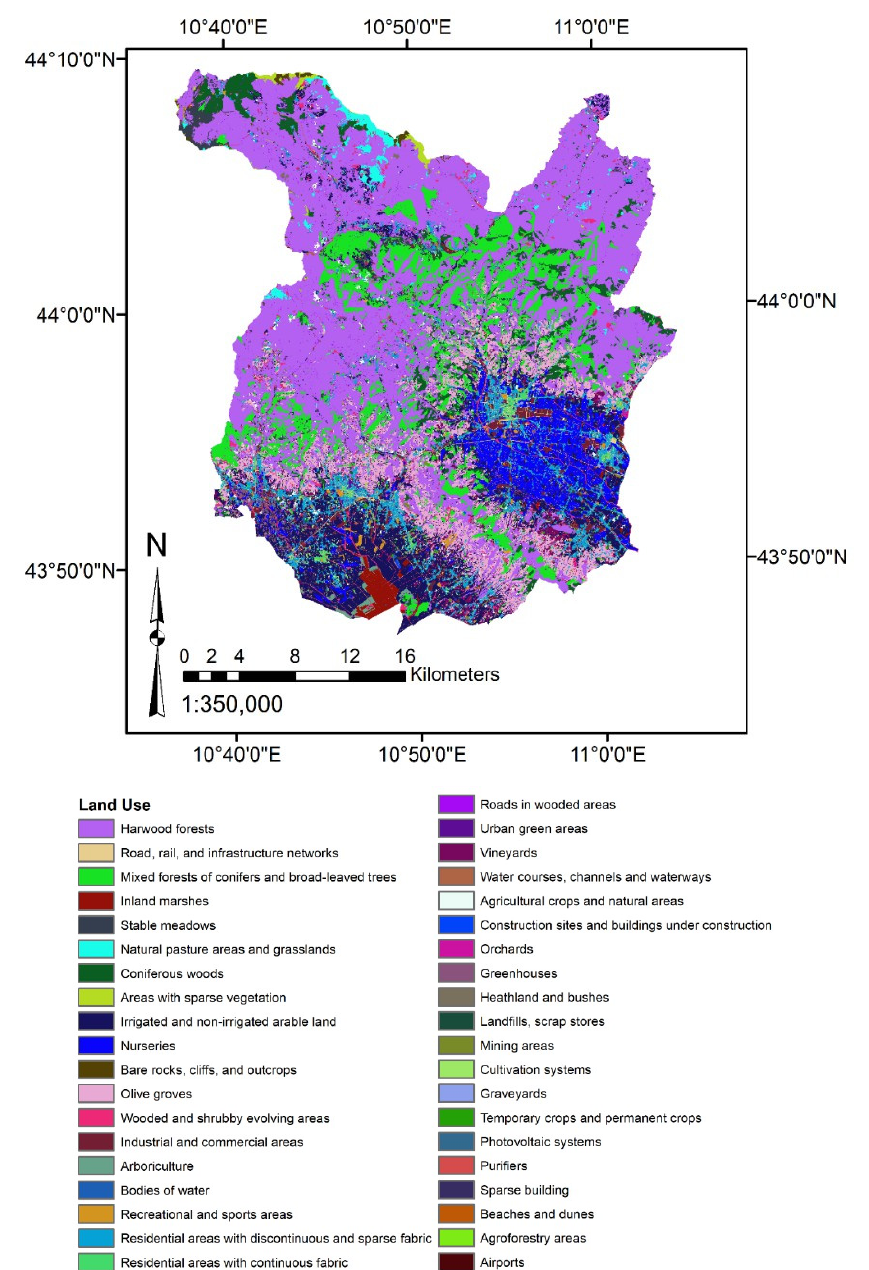
Figure A1. Land use map.